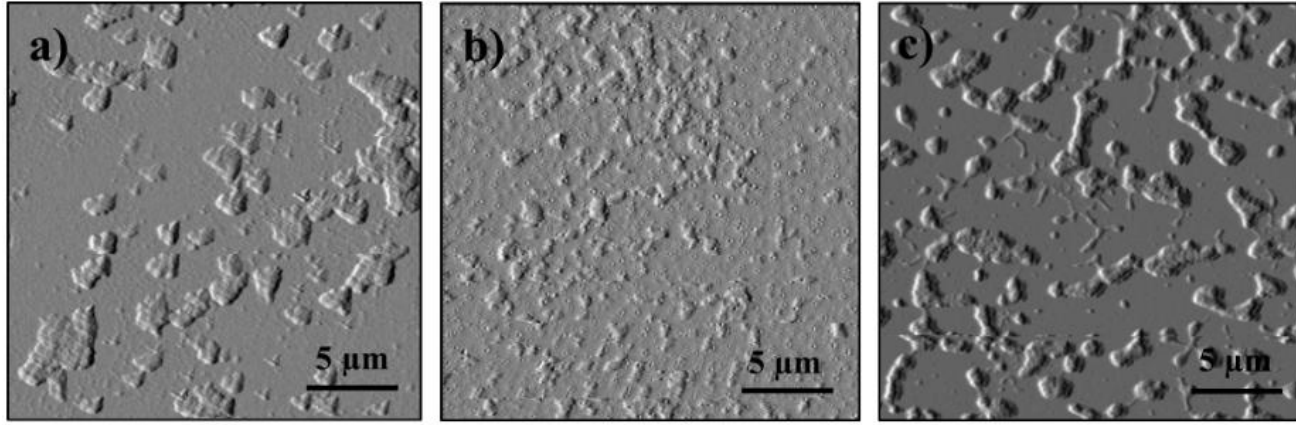
Figure 7. Comparison of the morphology of the resulting (after evaporation) state compared to ( a ) Initial conditions of model 2 after addition of ( b ) APR and ( c ) PIBSA.